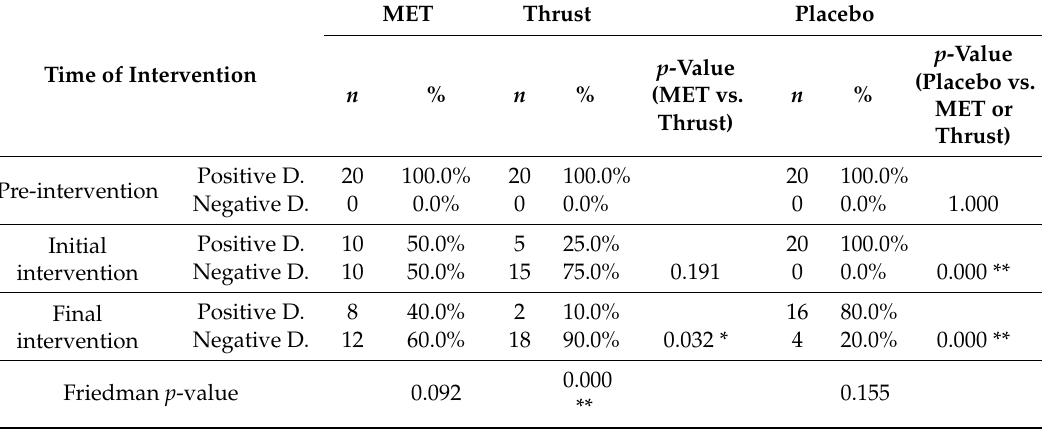
Table 3. Results of interventions comparing the muscle energy technique (MET) group, the thrust group, and the placebo